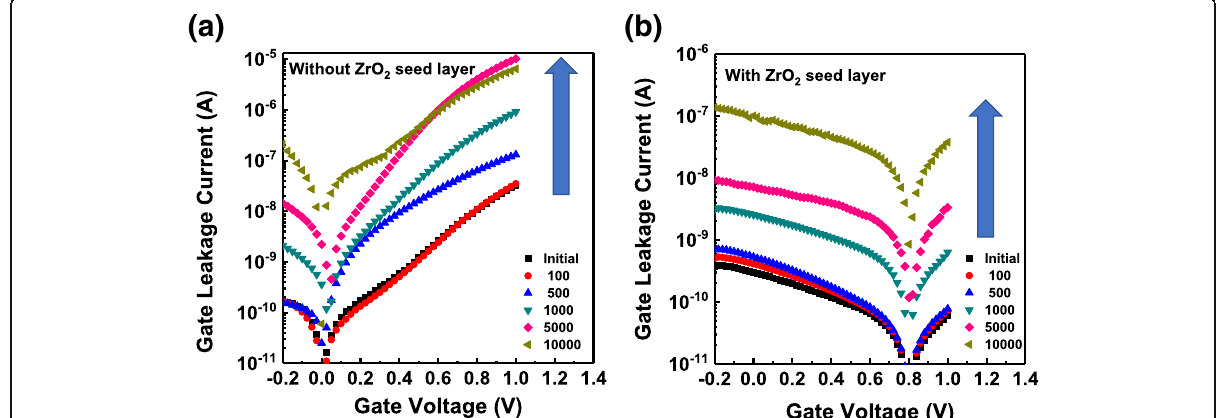
Fig. 6 Evolution of gate leakage current characteristics ( I G – V G curves) of HZO-based FeFETs a without and b with ZrO 2 seed layers with P/E cycling